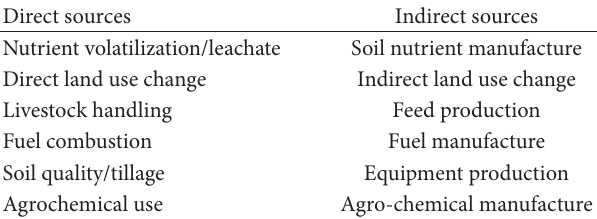
Table 3: Selected life cycle inventory considerations for